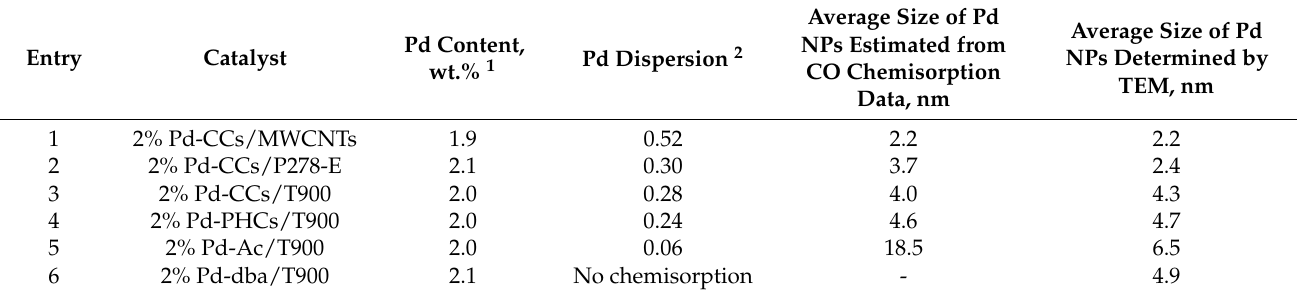
Figure 1. TEM images and the corresponding Pd nanoparticle (NP) size distribution histograms of the Pd/C catalysts: ( a ) 2% Pd-CCs/MWCNTs; ( b ) 2% Pd-CCs/P278-E; ( c ) 2% Pd-CCs/T900; ( d ) 2% Table 1. Palladium dispersion and average size of Pd NPs in Pd/C catalysts.